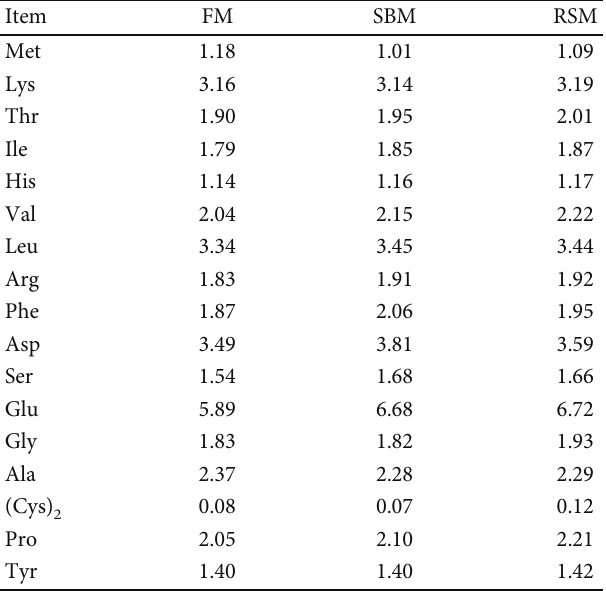
Table 2: Amino acid composition of the experimental diets (% dry matter).